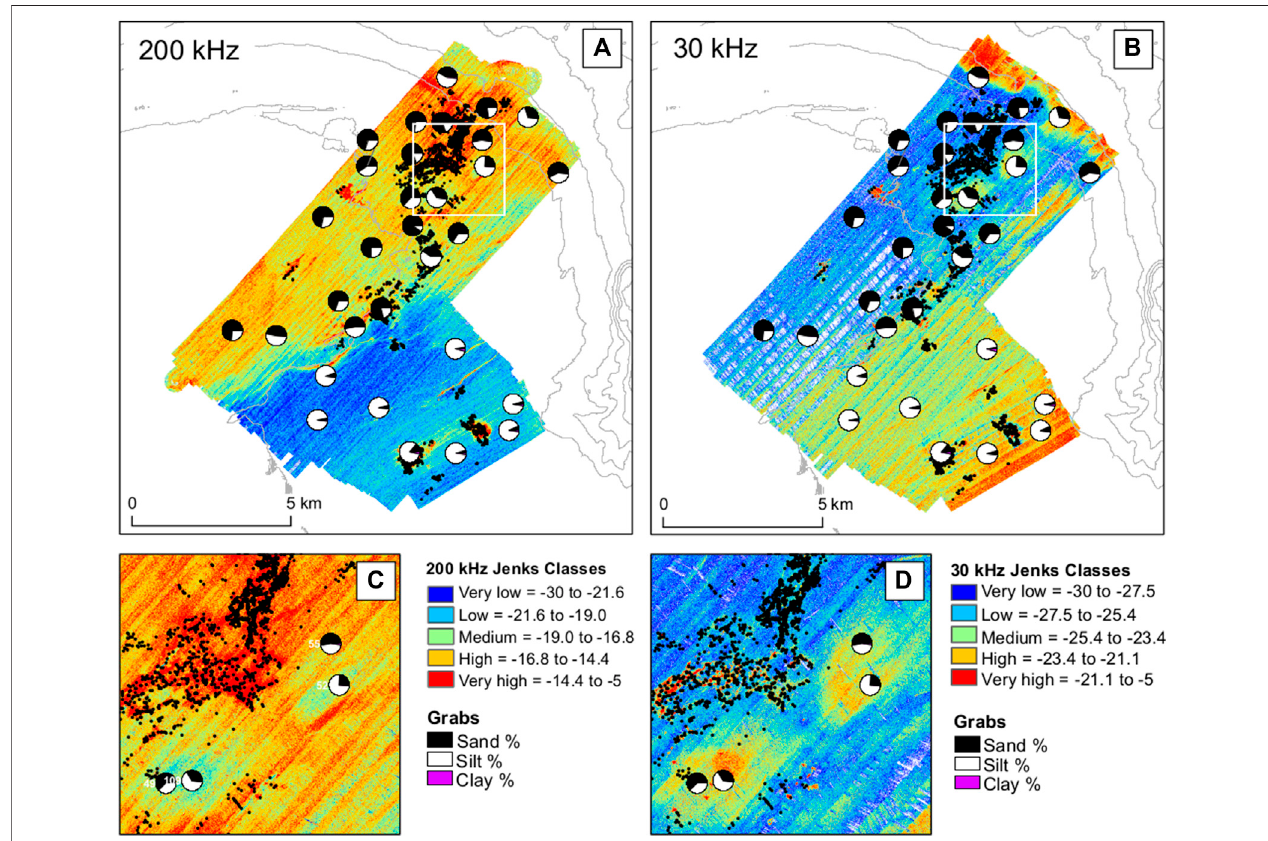
FIGURE4| SedimentgrabresultsandJenksNaturalBreaksbackscatterclassesfor (A) CalypsoHVF200 kHzmosaic,and (B) CalypsoHVF30 kHzmosaic.Grab results show sand-dominant classes in the North and silt-dominant classes in the South (grey lines: 50 m contours; black dots: seep base locations; mosaic resolution: 2 m; projection: NZTM). Inset of 200 kHz (C) and of 30 kHz (D ) show two depressionsin North Calypso HVF, with grab samples within each classi fi ed as coarse or very coarse silt.